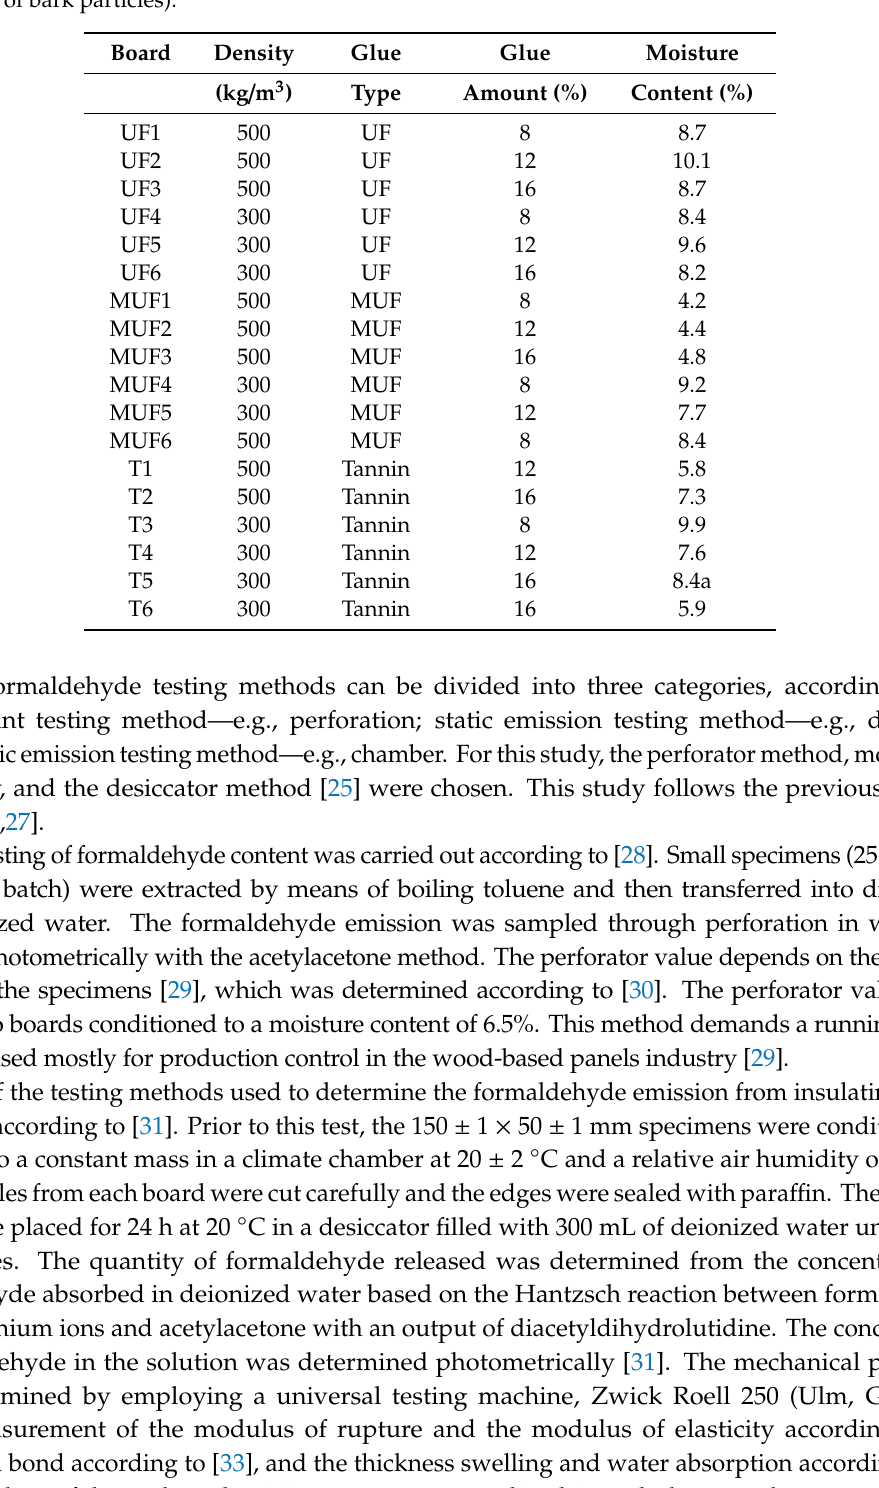
Table 1. Experimental design with the factors density and resin content (based on the oven-dried weight of bark